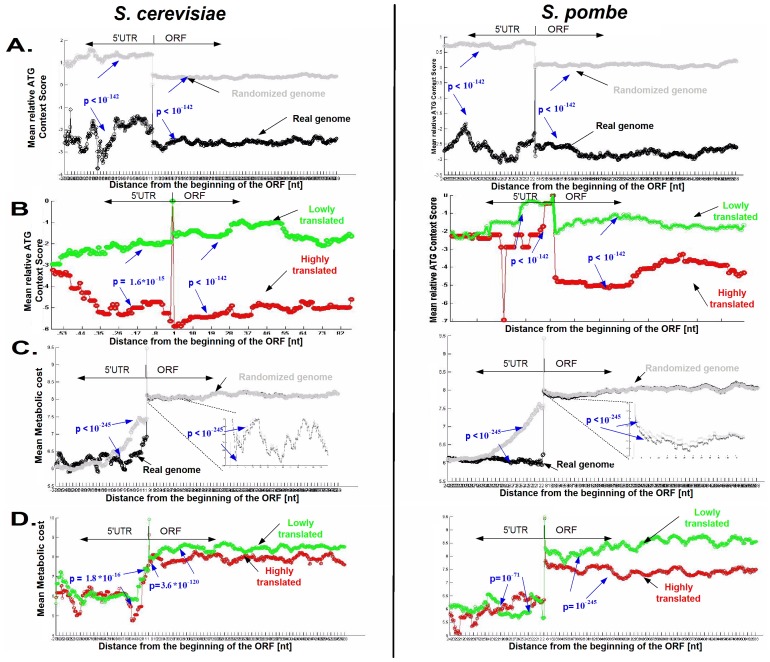
A. ATG context score profiles of real (black) vs. randomized (gray) genomes of S. cerevisiae and S. pombe near the beginning of the ORF.The real ATG context score profile is lower at all positions than the random profile. B. ATG context score profiles of genes with high (red) and low (green) ribosomal load in S. cerevisiae and S. pombe (top/bottom 10%). If non-main ATG codons appear in highly expressed genes they tend to have low context scores specifically near the beginning of the ORF. C. Metabolic cost of alternative initiation events for real (black) and randomized (gray) genomes of S. cerevisiae and S. pombe. D. Metabolic cost of translation commencing at alternative ATGs for highly (red) and lowly (green) expressed genes in terms of their ribosomal load for S. cerevisiae and S. pombe (top/bottom 10%). See supplementary Figure S36 for Distance to closest stop codon from alternative ATGs profiles.